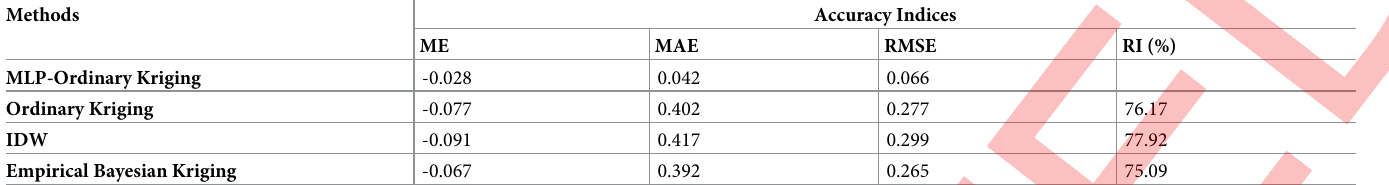
Table 4. Accuracy assessment of indices (error metrics) at validation points for SOC content estimated using different interpolation